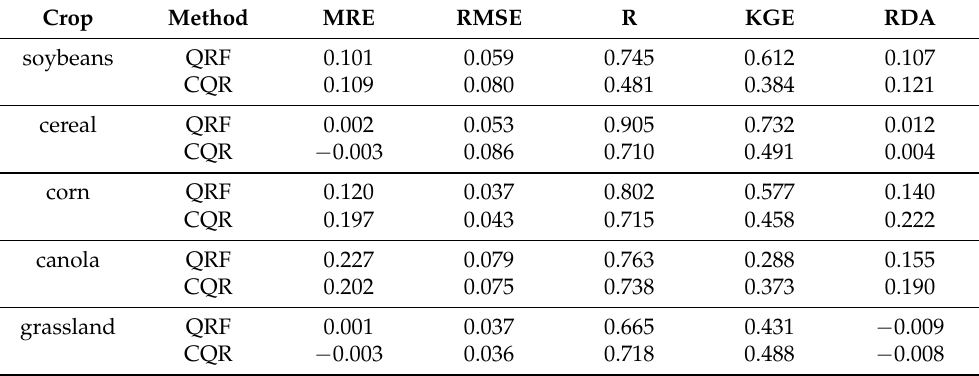
Table 4. Evaluation parameters of the error between estimated SSM and in situ